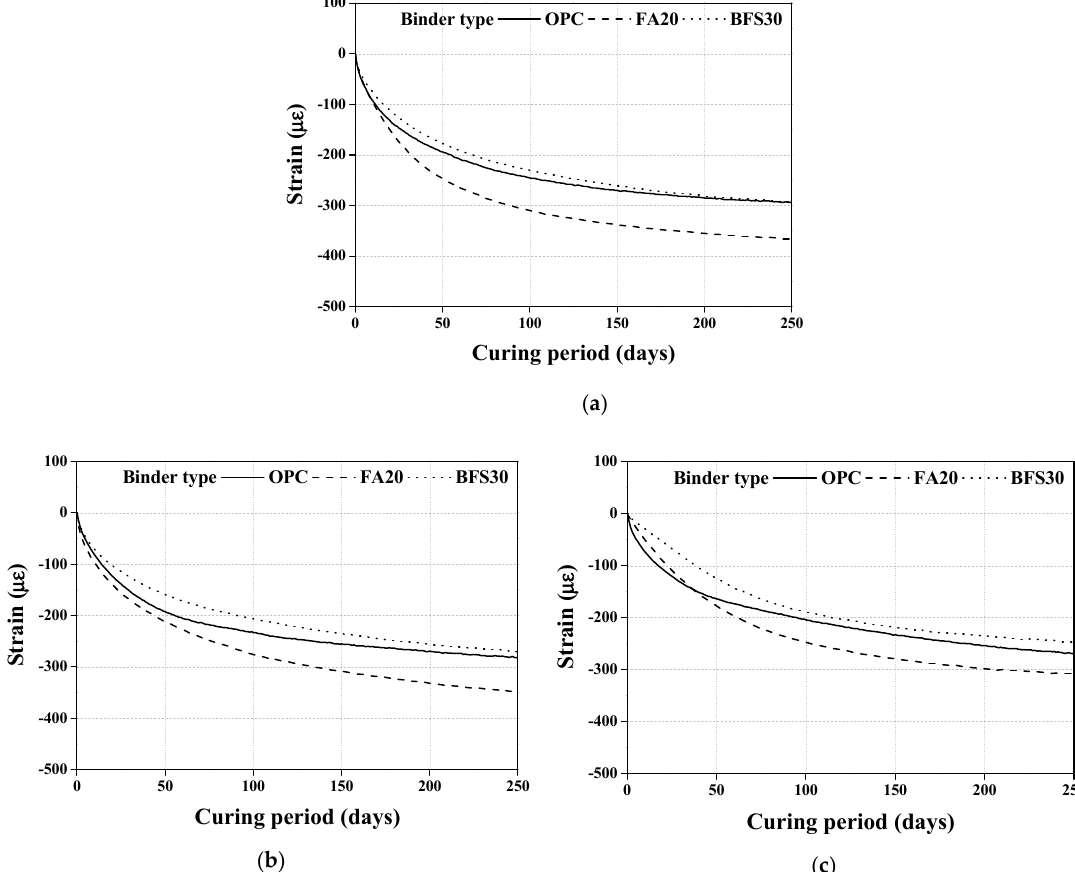
Figure 7. Results of drying shrinkage test. ( a ) Substitution ratio of steel slag (0%); ( b ) Substitution ratio